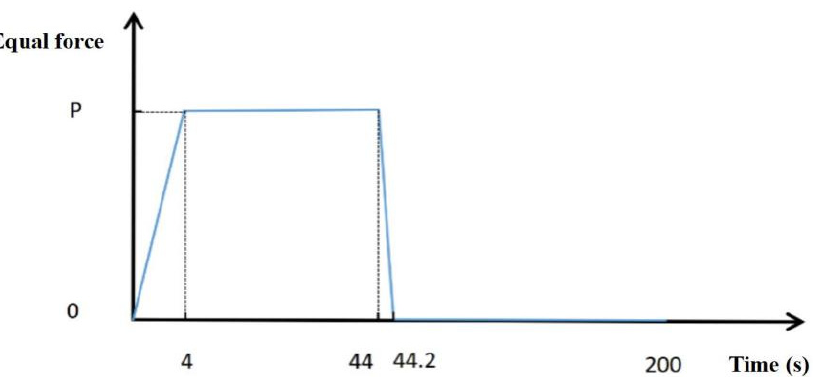
Figure 2. Equal force schedule.